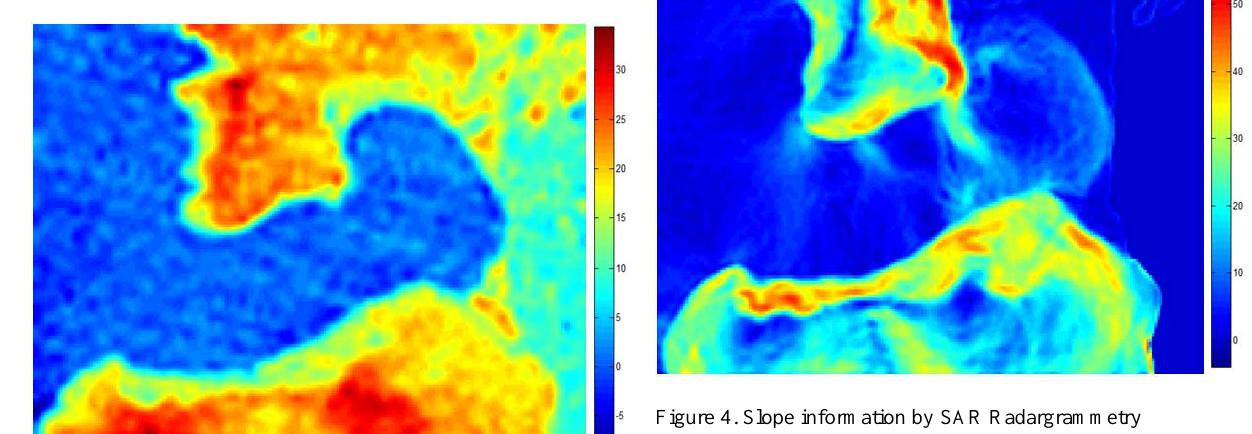
Figure 4. Slope information by SAR Radargrammetry